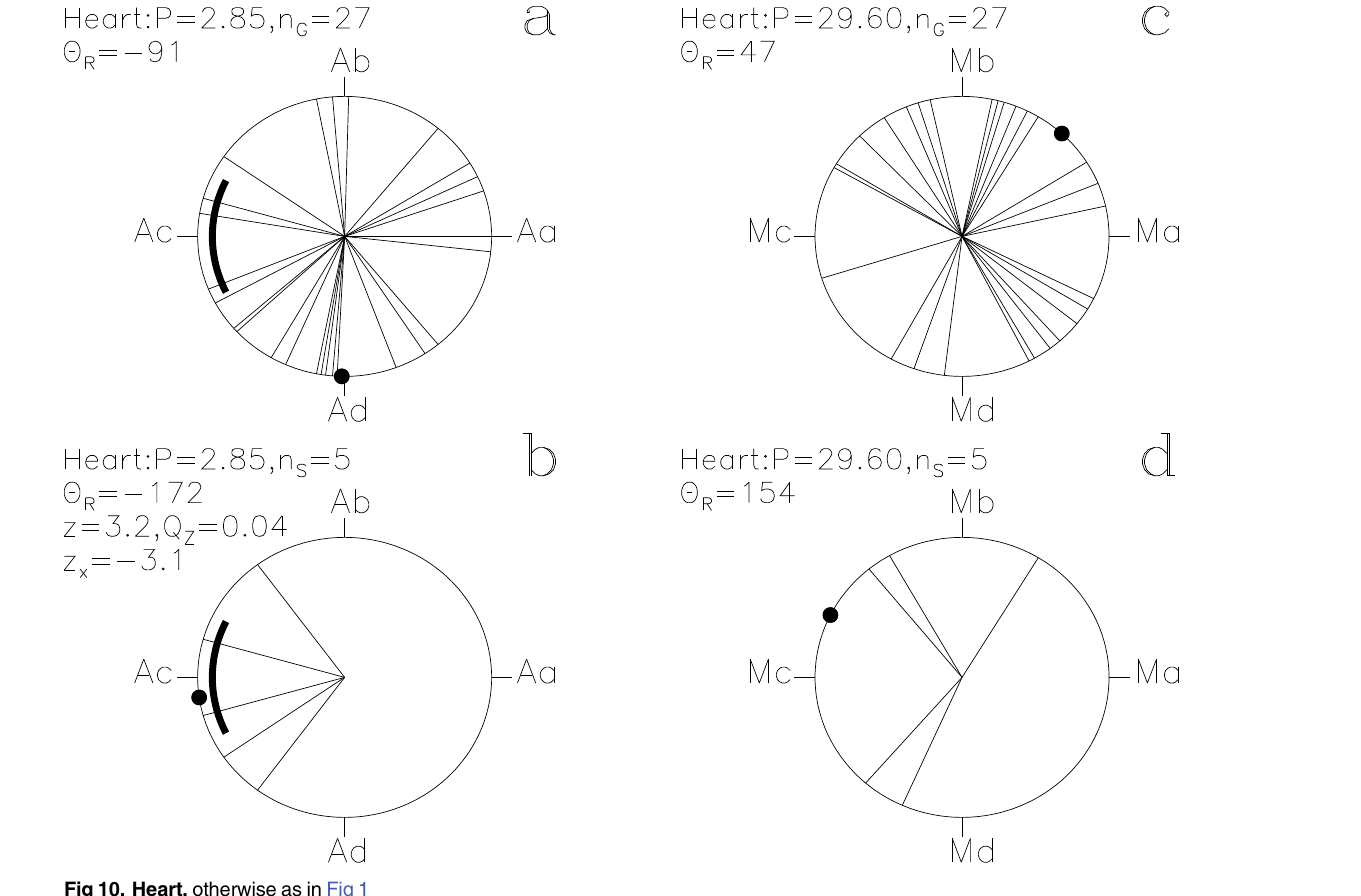
Fig 10. Heart. otherwise as in Fig